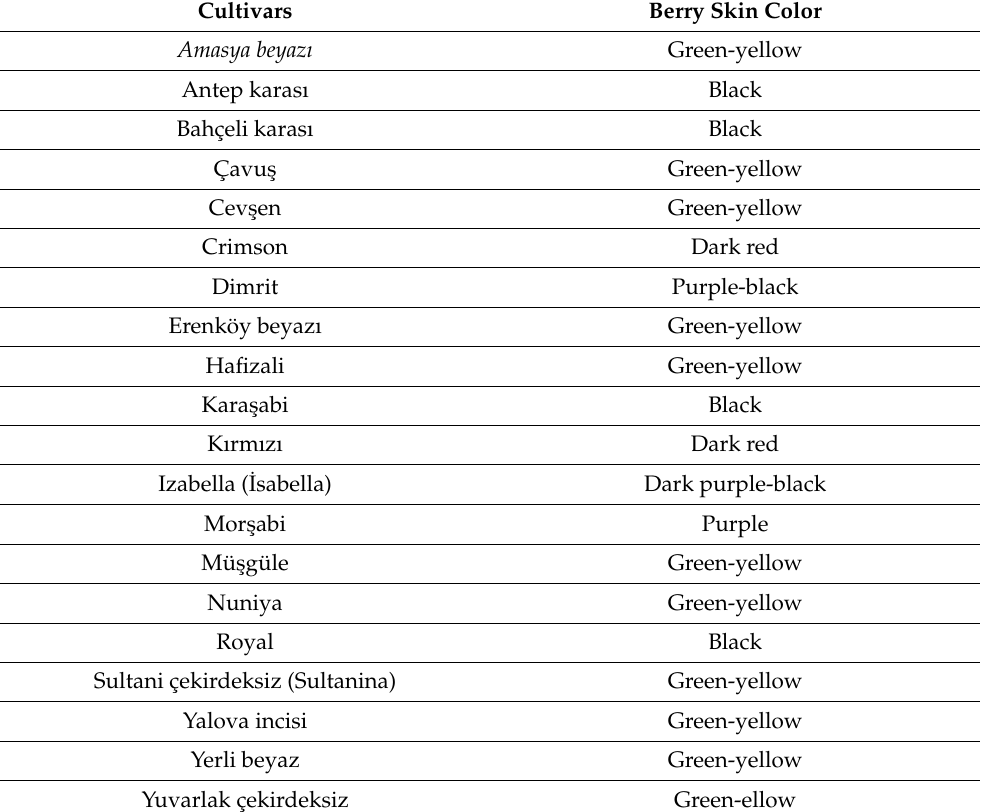
Table 1. External (skin) berry color of